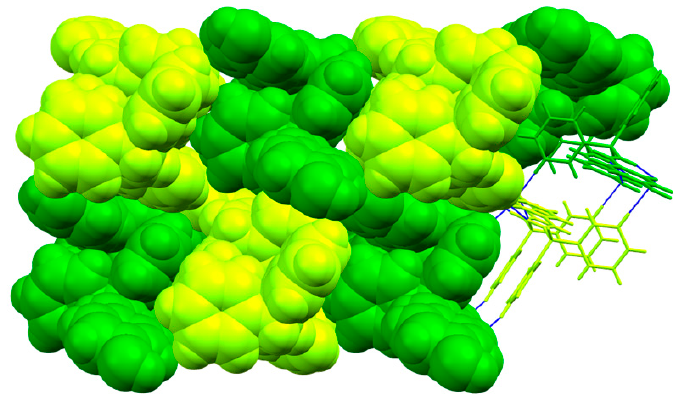
Figure B3. Packing diagram for oOHsaladpm .